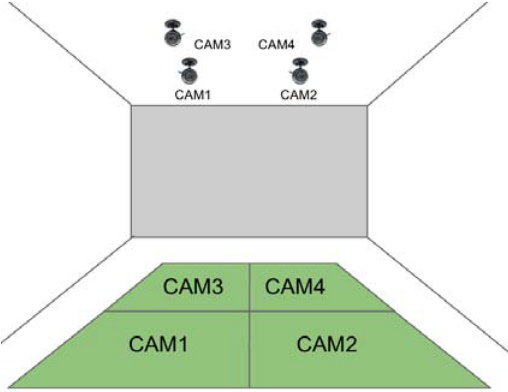
Figure 17. Graphical overview of the auxiliary platform for measuring the real position of robots. Note the four cameras distributed on the ceiling of the game field.